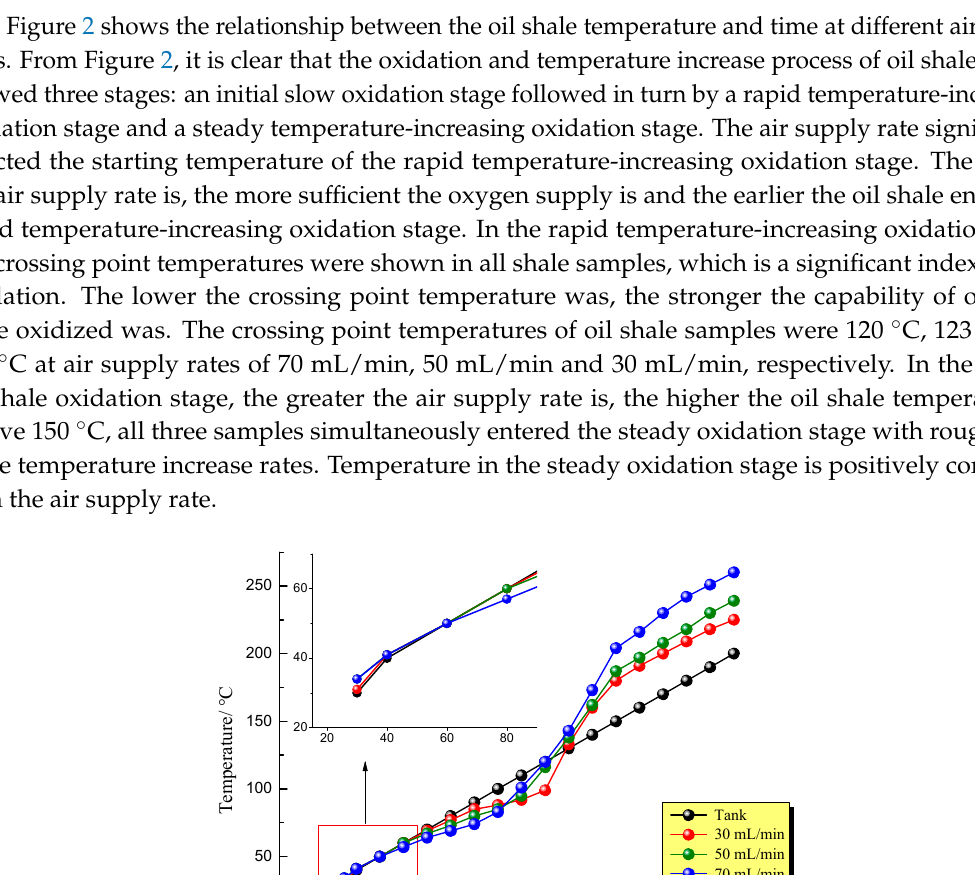
Figure 1. Temperature-programmed system: ( a ) air supply system; ( b ) temperature-programmed reaction system; ( c ) gas concentration detection system.